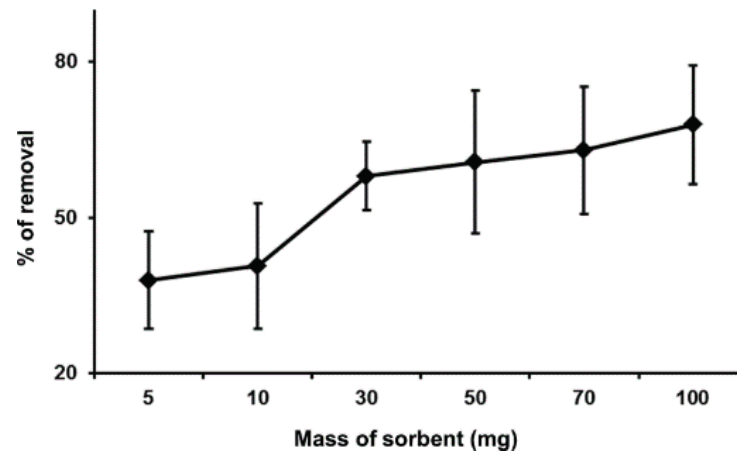
Figure 5. Effect of dosage on the percentage removal of Hg(II) (conditions: 10 mL of 200 ppb of Hg(II), at pH 7 and 25 °C, contact time of 10 s).